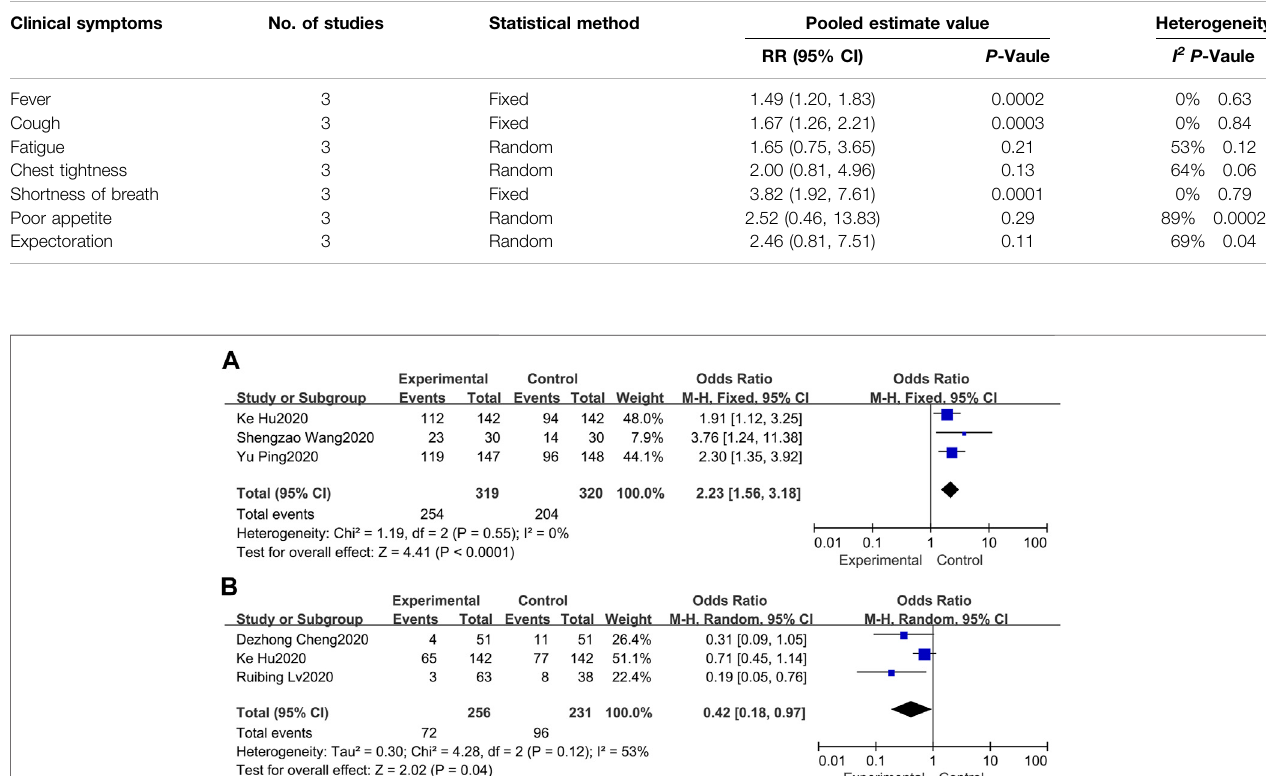
Frontiers in Pharmacology |